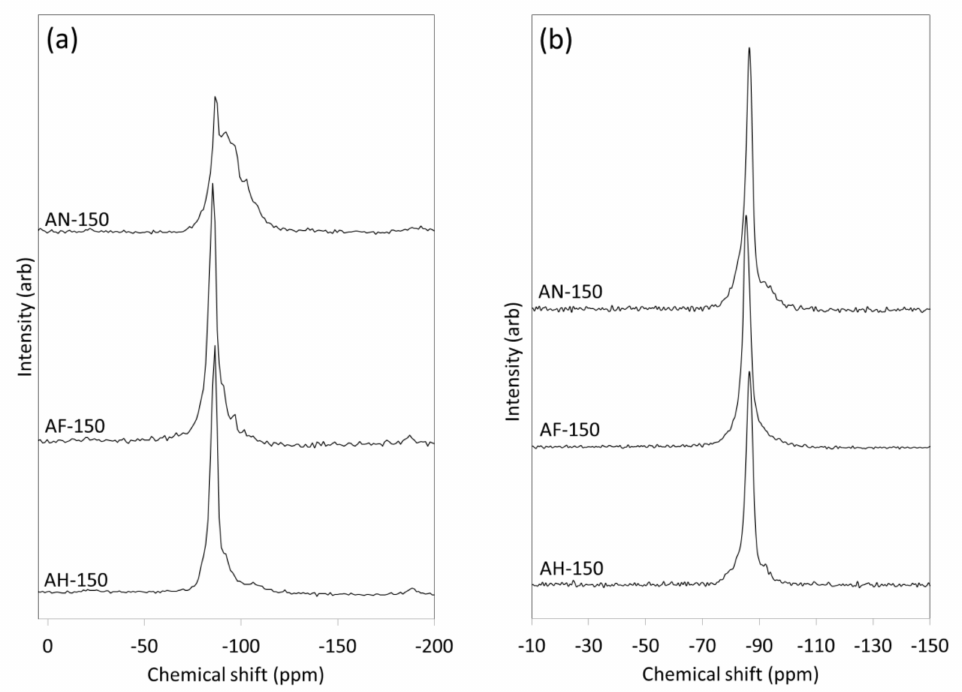
Figure 3. ( a ) 29 Si MAS NMR spectra and ( b ) 1 H- 29 Si CP MAS NMR spectra of hydrothermal products of amber container glass and aluminium nitrate (AN-150), aluminium foil (AF-150) and amorphous aluminium hydroxide waste (AH-150) synthesised for 150 h in 4.5 M NaOH (aq) at 100 ◦